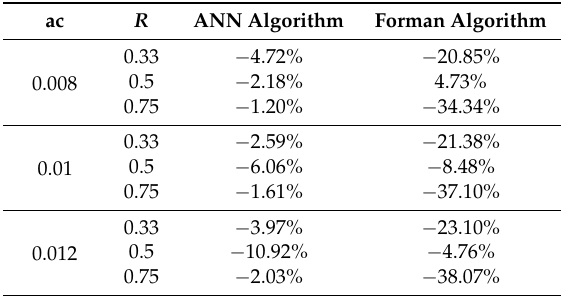
Table 4. The errors of the results by two models for Al7075-T6.